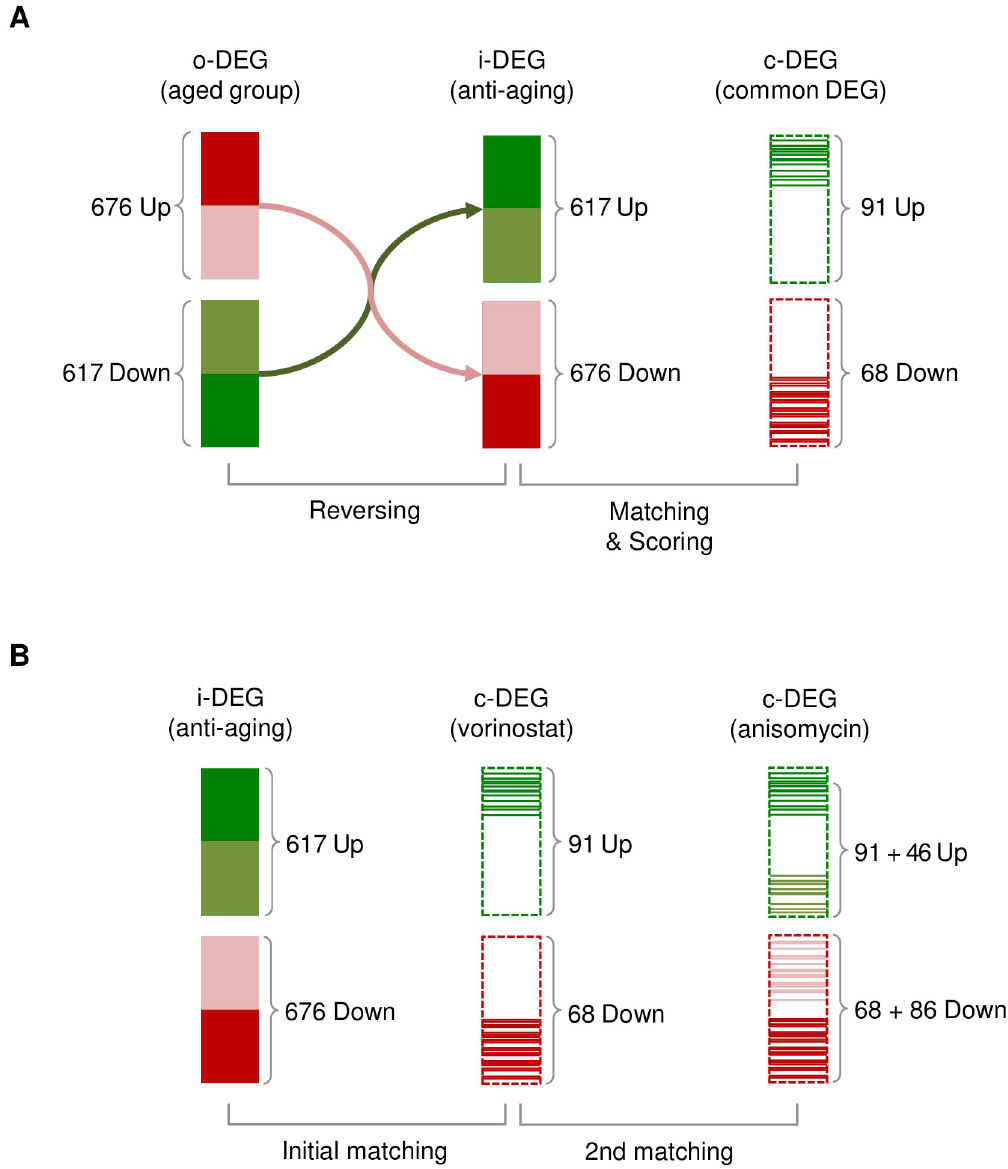
Fig 2. Flow of initial and second matching. (A) To identify a differentially expressed gene (DEG) pattern that is expected to have anti-aging effects, we reversed the original DEGs (o-DEGs) of the aged group. The i-DEGs comprised 617 up-regulated genes and 676 down-regulated genes. We performed matching with each drug-induced DEG (d-DEG) to select common DEGs (c-DEGs). In the case of vorinostat, 91 up-regulated genes and 68 down-regulated genes were shared with the i-DEG pattern. (B) To maximize the number of reversed genes, second matching was performed. Excluding the drugs chosen in initial matching, drug-induced DEGs (d-DEGs) of each drug were matched with genes not covered by the first drug. In the case of vorinostat and anisomycin, c-DEGs of vorinostat covered 159 genes, and anisomycin, 132 genes. senescent cells were mainly large and characterized by an irregular distribution of fluorescence [31, 32]. To investigate the morphological alterations that occur in aging nuclei, hydrogen per- oxide was used to induce ROS-based senescence in HL-60 cells. The morphology of DAPI- stained nuclei was analyzed (S5 Fig), and the ratio of distorted: altered nuclear shapes were counted. Following treatment with 10 μ M H O , the first CMap drug treatment restored the 2 2